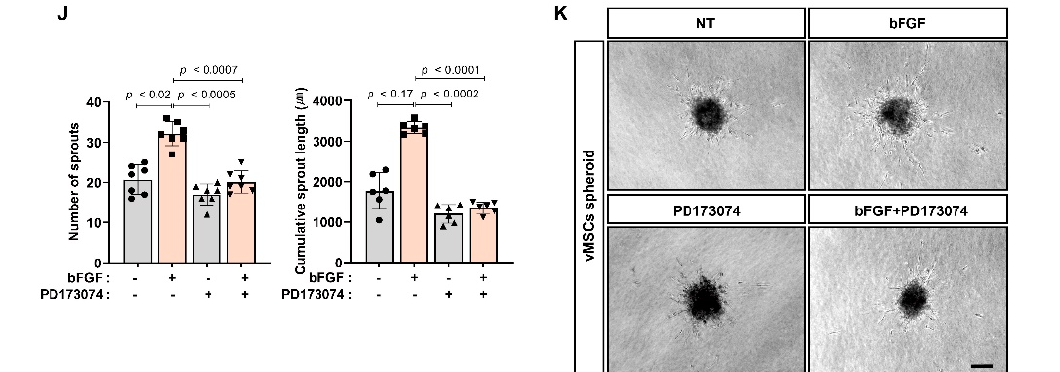
Figure 1. In vitro angiogenic sprouting of vMSCs in response to bFGF. ( A ) qRT-PCR analysis of mRNA expression of CD34, CD133, VE-cadherin, HGF, and bFGF in vMSCs and MSCs. HUVECs, SH-SY5Y, and U87 cells were used as positive controls that are known to express each gene. ND; not detected. ( B-E ) Sprouting capacity of vMSC spheroids and MSC spheroids incubated with VEGF (25 ng/mL or 50 ng/mL) and bFGF (25 ng/mL or 50 ng/mL). Representative images are shown in ( D ) and ( E ). ( F ) qRT-PCR analysis of mRNA expression of VEGFR2 in vMSCs and MSCs. HUVECs were used as positive controls that are known to express VEGFR2. ( G , H ) Western blot analysis of phosphorylated ERKs (pERKs) and ERKs in vMSCs treated with VEGF (25 ng/mL) and bFGF (25 ng/mL) for 10 min. α -Tubulin was used as an internal control. ( H ) Densitometric analysis of Western blot results (three independent experiments). ( I ) Western blot analysis of phosphorylated ERKs (pERKs) and ERKs in vMSCs pretreated with PD173074 (10 nM, 25 nM, or 50 nM) for 3 h followed by treatment with bFGF (25 ng/mL) for 10 min (two independent experiments). α -